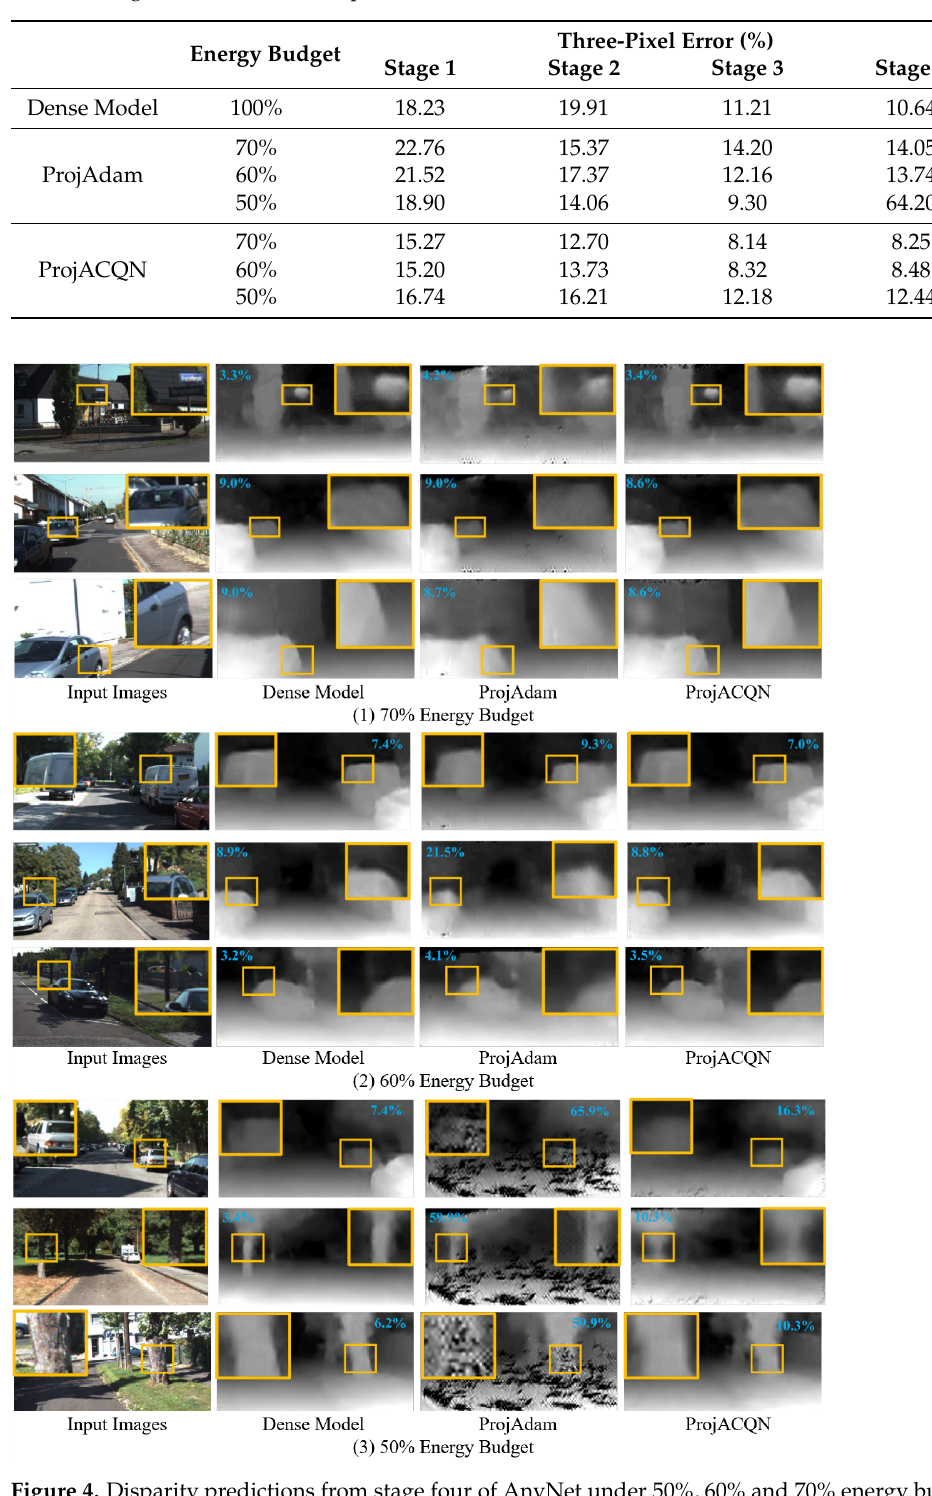
Figure 4. Disparity predictions from stage four of AnyNet under 50%, 60% and 70% energy budgets on KITTI-2012. The percentages in the figure represent the three-pixel errors, the lower the better. Evaluation results of ProjACQN are marked in